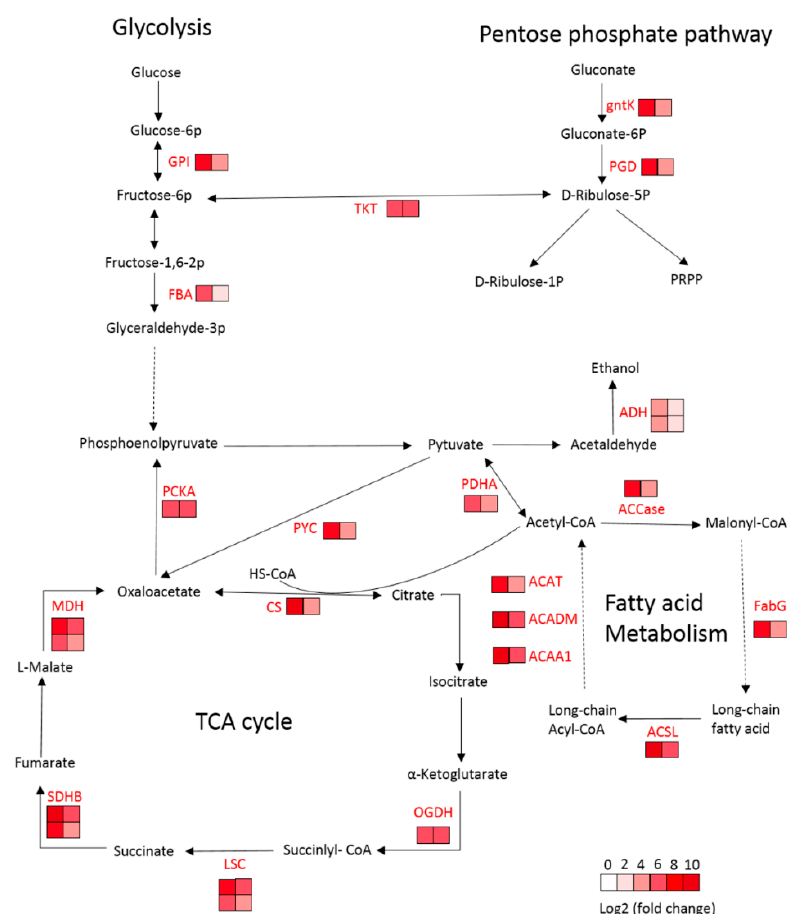
Figure 7. Visualization of DEGs involved in carbohydrate metabolism and fatty acid metabolism. Substrates are in black font, and enzymes in red font. The color of boxes represents Log 2 (fold change) values based on the transcriptome results. The values are shown by a color gradient from low (white) to high (red). The left column of boxes represents the Log 2 (fold change) value obtained from LS comparison setting, and the right column represents that from LR comparison setting. Each row of boxes represents one DEG. Solid arrows represent direct processes, and dashed arrows represent indirect processes.